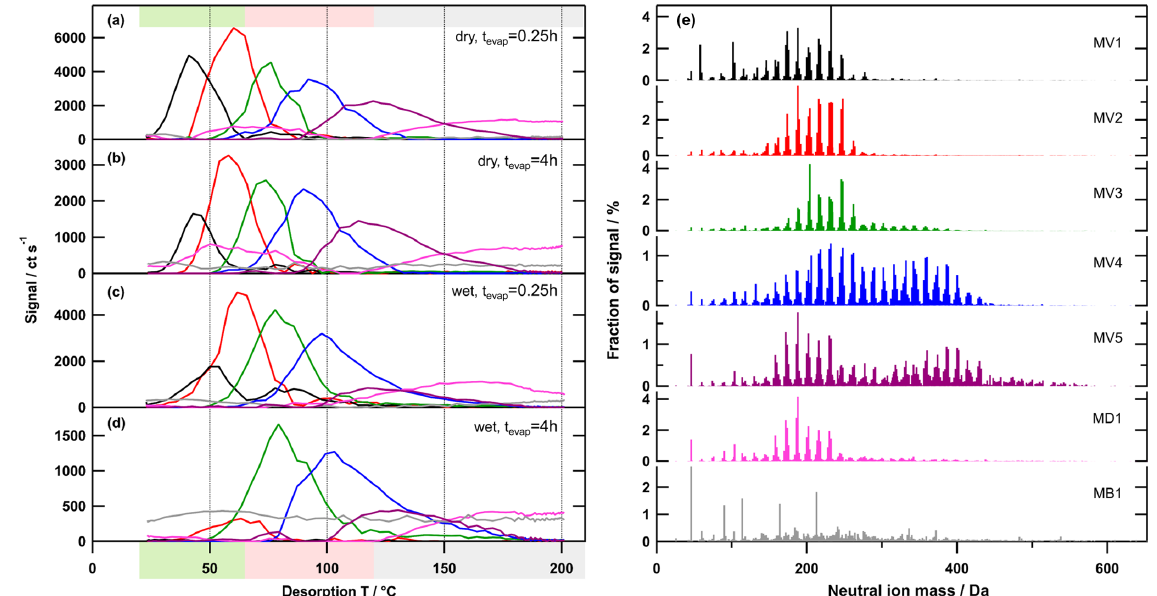
Figure 6. Factor thermograms (a–d) and factor mass spectra (e) for the 7-factor solution for the medium-O : C case. Each factor mass spectrum is normalised. The colour code is the same for both panels. Background colours in the panel on the left indicate the volatility classification derived from T max – C ∗ sat calibrations (green – SVOC; red – LVOC; and grey – ELVOC). Note the different scaling for the y axes in (a) – (d)